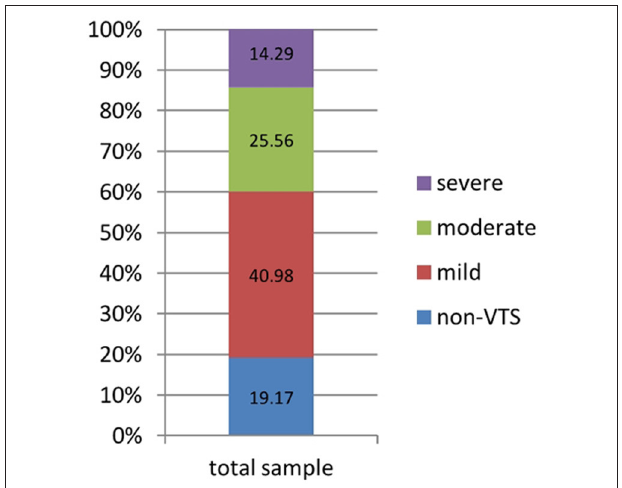
FIGURE 1 | Distribution of different levels of VTS among